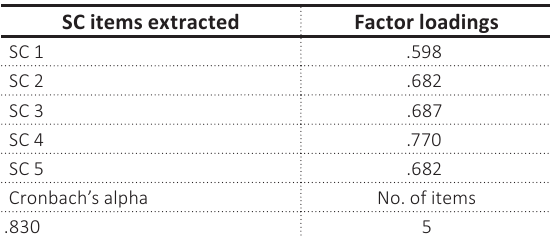
Table 8. Factor: Employee Performance